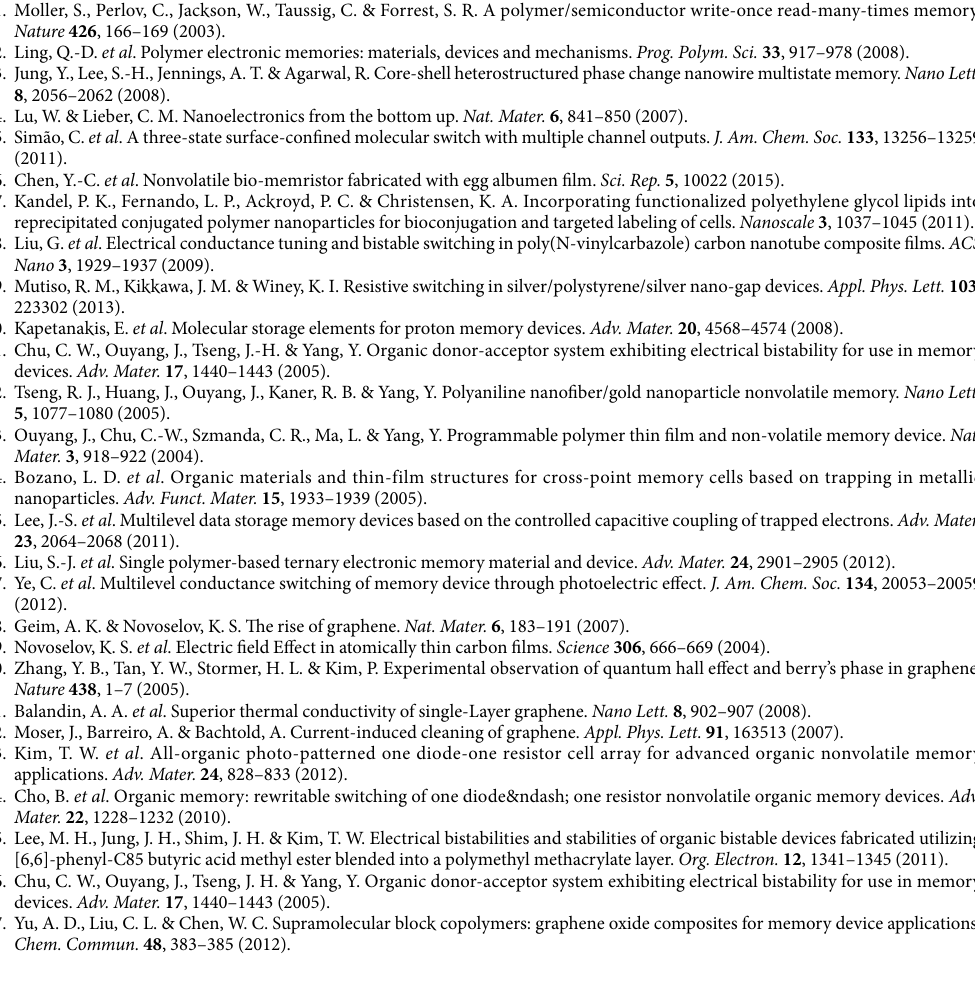
In summary, nonvolatile ternary memory devices based on the composite thin films of PS and GO were illustrated. A stable intermediate state was observed under positive and negative applied voltages in the ITO/ PS + GO/Al device. The fitted I - V curves indicated that the carrier transport mechanisms correlation with the memory behaviors of the ITO/PS + GO/Al devices were ascribed to SCLC, thermionic emission, and Ohmic conductions. The ITO/PS + GO/Al device exhibited a stable endurance of over 10 4 cycles and long retention time of 2 × 10 5 s. HRTEM and XPS analyses clearly demonstrated the reduction at the interface of the GO and oxidation of the top Al electrode. Nonvolatile ternary memory devices with a single organic composite layer bid fair to frontier applications in next generation memory devices with ultra-high density storage capacities.